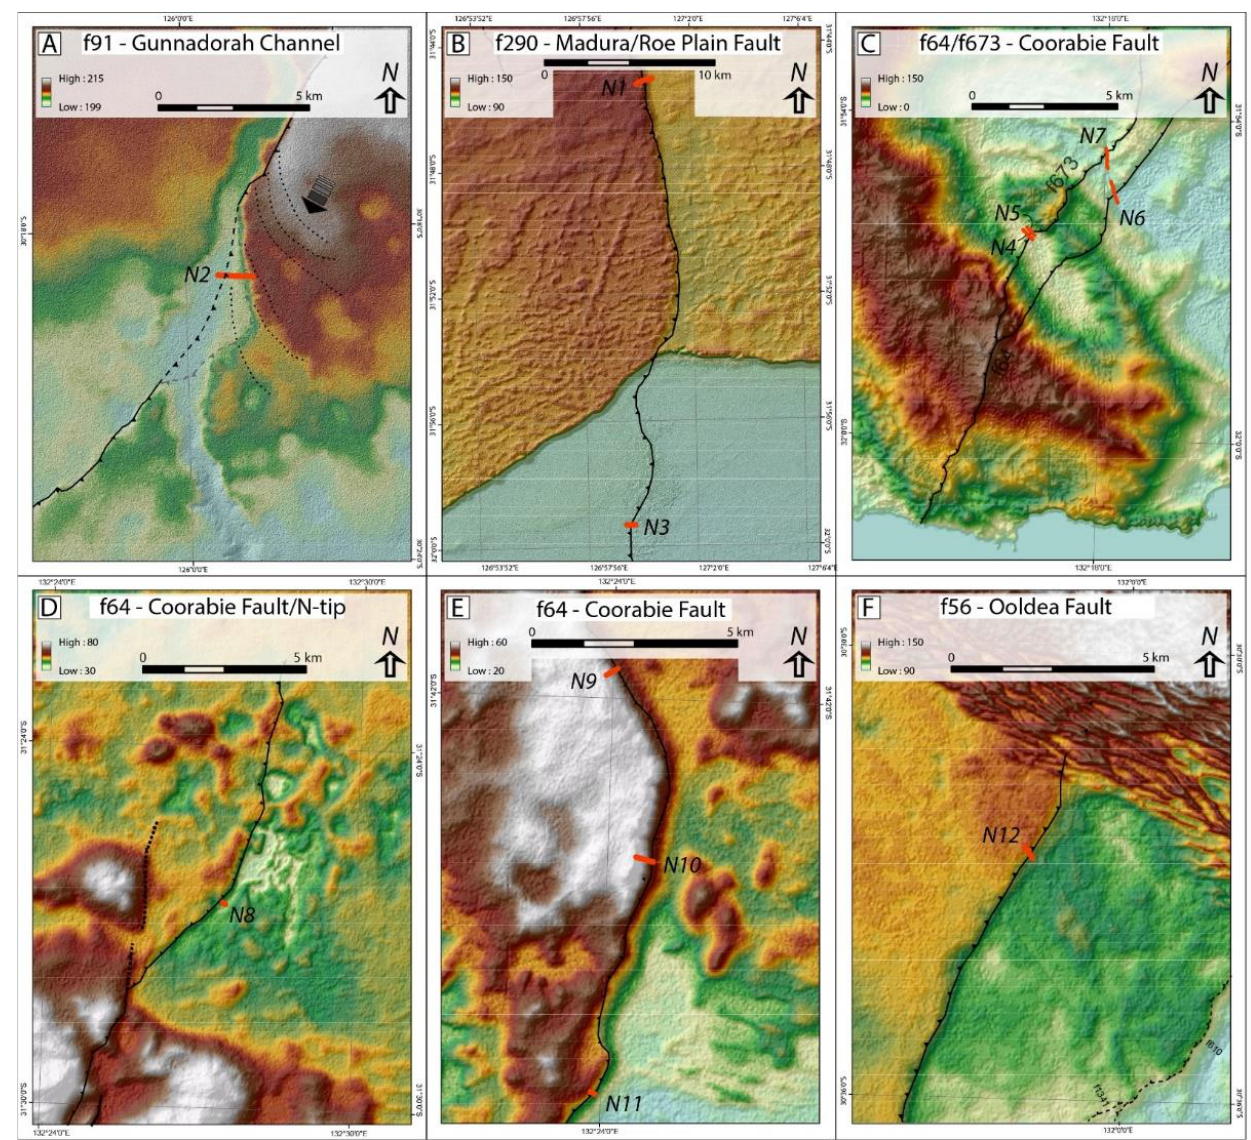
Figure 2. Maps of the Nullarbor and Roe Plains showing locations of GPR transects in their local context. ( A , B ) 12 m TanDEM-X elevation models showing locations of GPR transects N1 – N3, ( A ) black dashed line: inferred fault trace; grey dashed line — geomorphic scarp set back from inferred fault trace through erosion by the channel; dotted black lines: paleo-channel banks indicating a progressive shift of the location of scarp defeat by the channel towards the SSW. ( C – F ) 30 m SRTM elevation models showing locations of GPR transects N4 – N12.